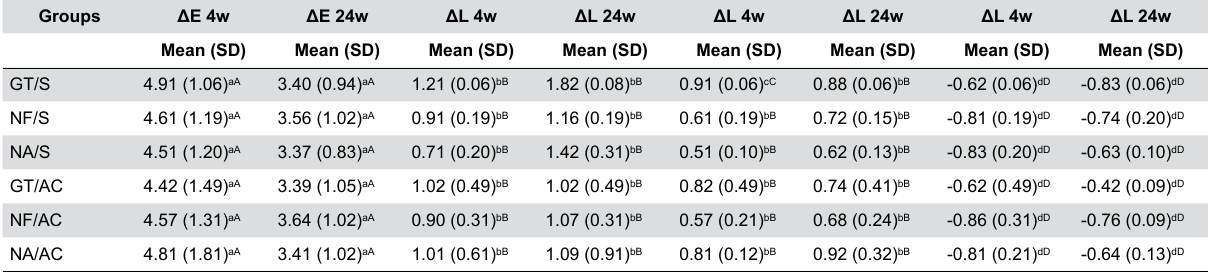
*Coefficients with the same letter show no statistical difference among the means of color variation. *Lower-case letters compare the rows. *Capital letters compare the